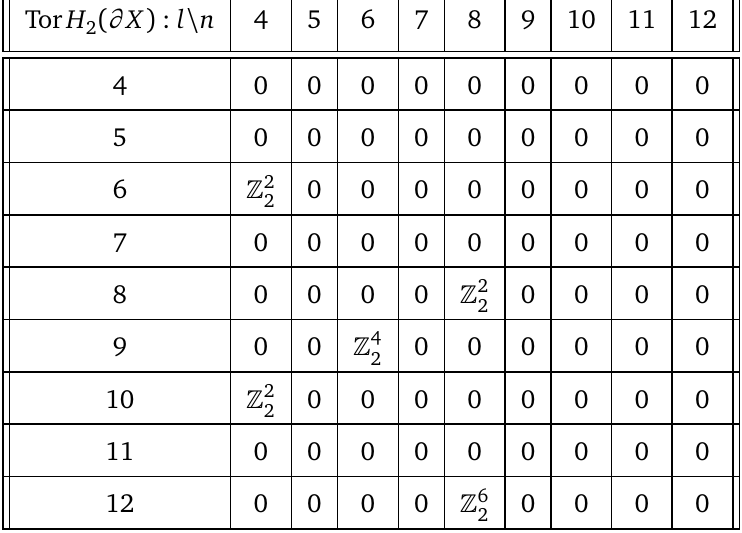
Table 5: The 1-form symmetries for the hypersurfaces of type X { : 0 = x 2 + y n − 1 + yu 2 + uv l , l increases downwards, n increases to the 7,1 } ( 2, n − 1,2, l ) right. ( ∂ X ) : l \ Tor H 2